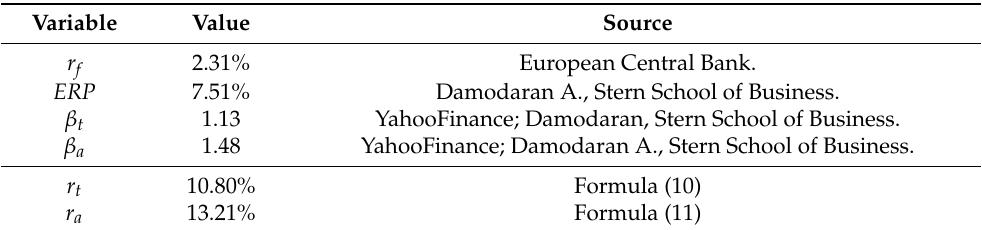
Table 1. r t and r a estimation for Europe.